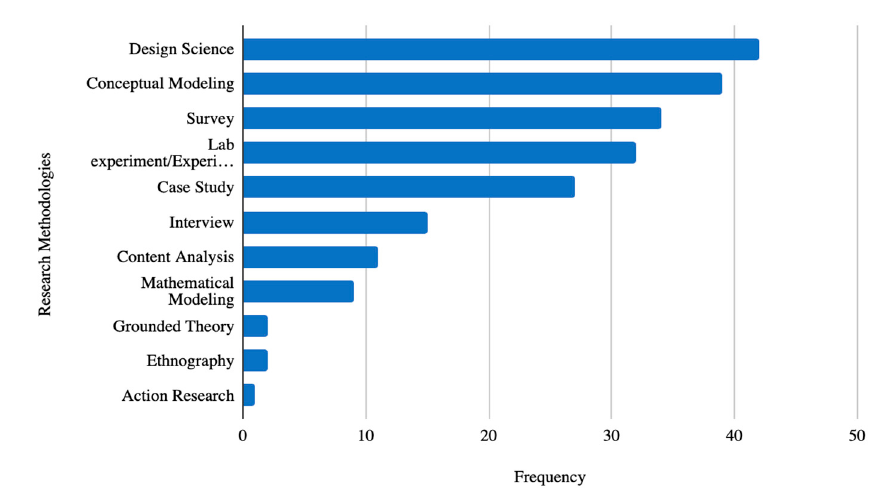
Figure 5. Frequency of research